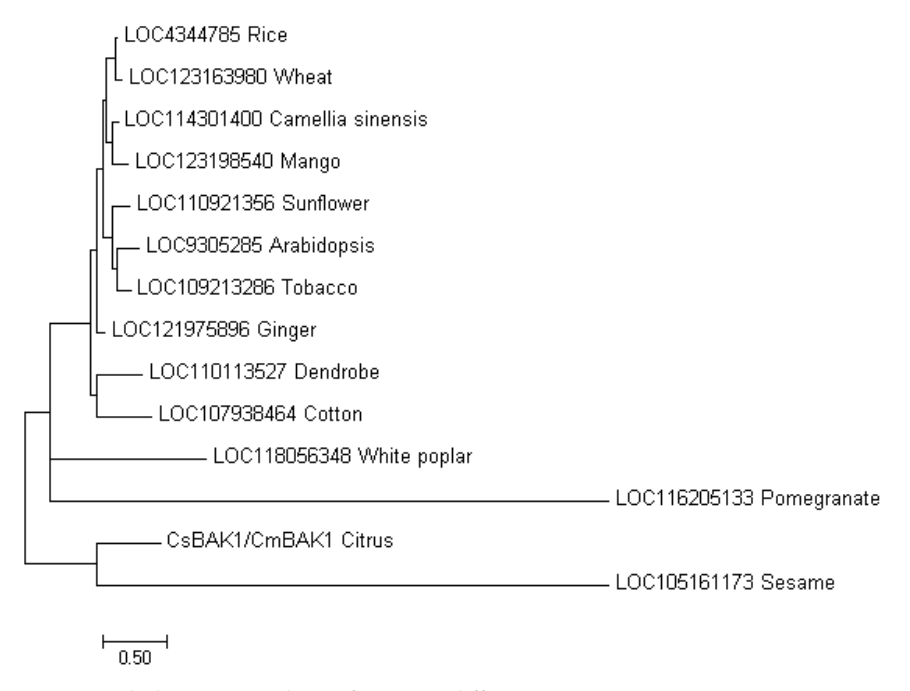
Figure 4. Phylogenetic analysis of BAK1 in different citrus species.